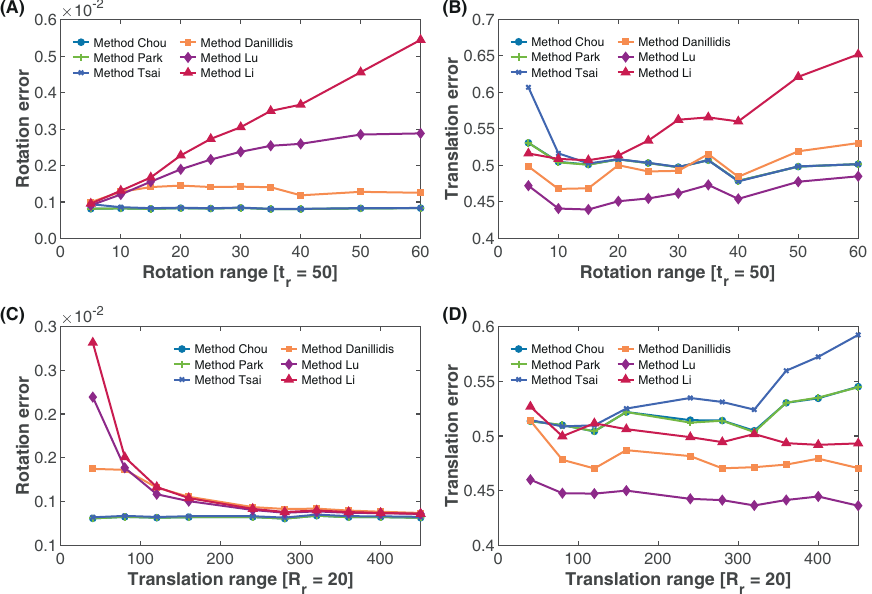
Fig 7. Effect of rotation and translation motion on estimation accuracy. (A) Effect of rotation motion on rotation accuracy with fixed translation range. (B) Effect of rotation motion on translation accuracy with fixed translation range. (C) Effect of translation motion on rotation accuracy with fixed rotation range. (D) Effect of translation motion on translation accuracy with fixed rotation range.